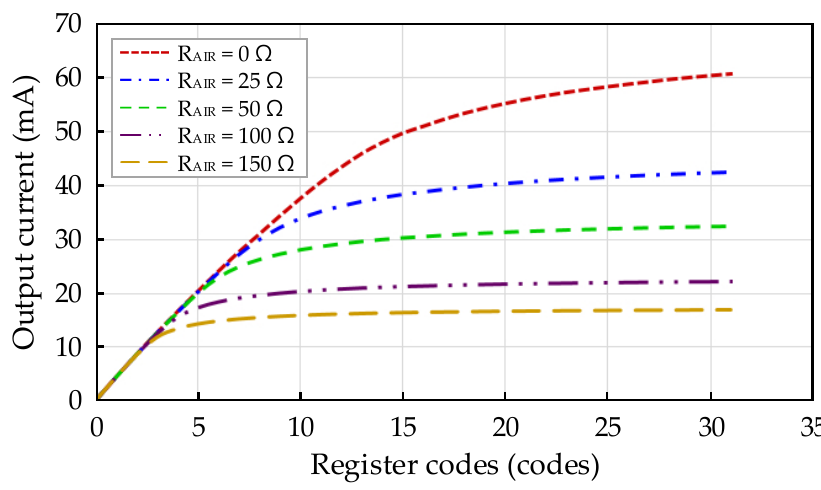
Figure 11. Output current measurement result of current generator based on load resistance. The transfer function measurement results of the fabricated readout IC are shown in Figure 12. The frequency was swept using a dynamic signal analyzer, and the transfer function was measured between the input stage of the three op amp IA and the output stage of the 4th-order LPF. The designed three op amp IA comprised two amplification stages. The registers of the programmable resistors of the first and second stages were composed of 5 bits and 4 bits, respectively. The measurement indicated that the minimum and maximum gains of the three-op amp IA were 4.08 dB (1.60 times) and 47.47 dB (236.28 times), respectively. In addition, because the cutoff frequency of the 4th-order LPF was designed to be 1 kHz, the bandwidth of the readout IC was approximately 1 kHz. The four graphs in Figure 12 describe four levels of gain that change by approximately 10 dB, showing the register settings at the same time.